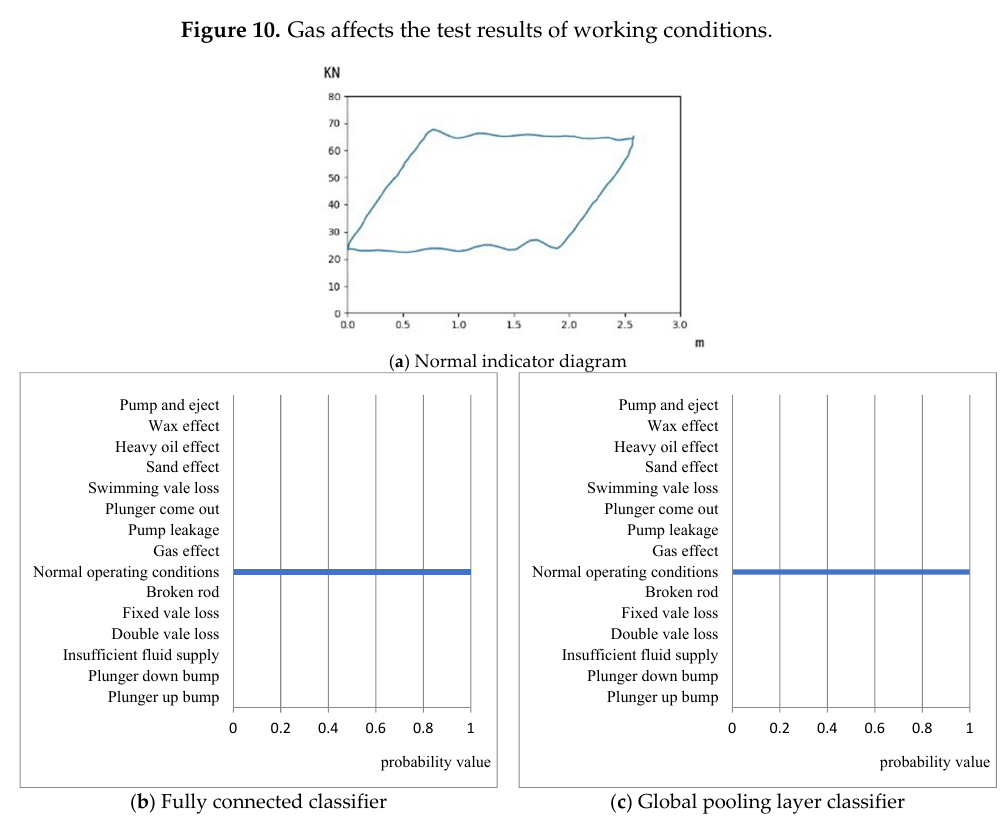
Figure 11. Test results under normal conditions.